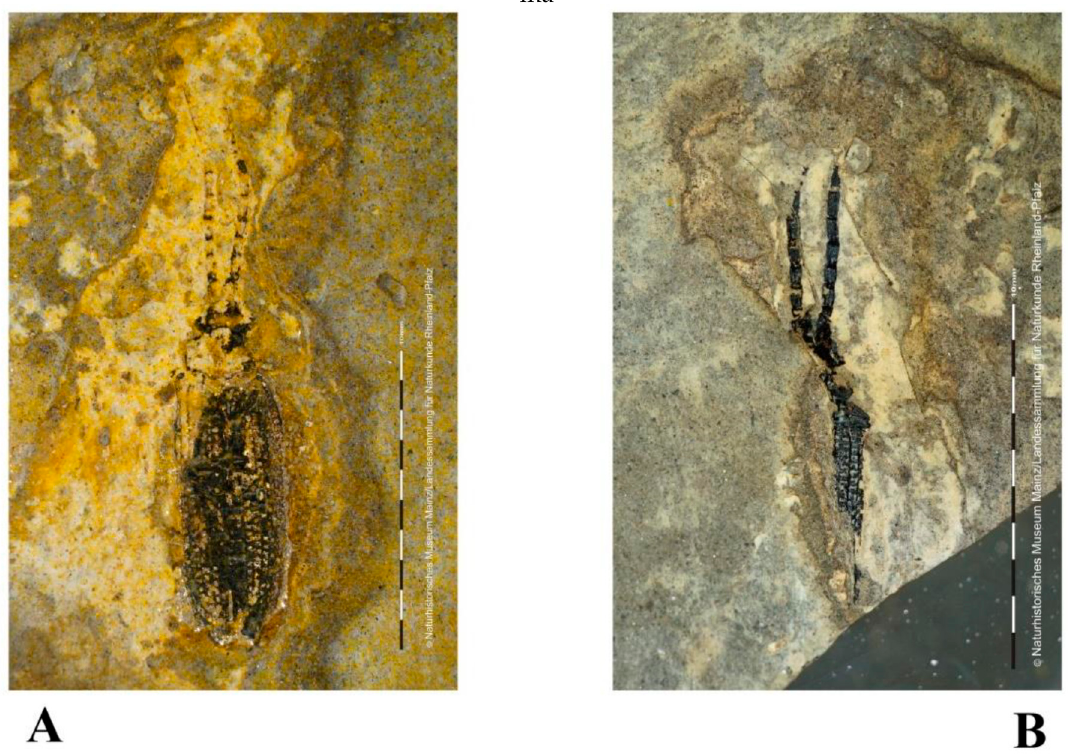
Figure 21. Cupedinae (Cupedidae). Cupes lutzi sp. nov. from Eckfeld (Palaeogene, Eocene, Lutetian; Eifel, Eckfeld Maar): A – B —holotype, PE 200001141-a (LNNR), part (A) and PE 200001141-b (LNNR), counterpart. Scale for each picture provided. Original.